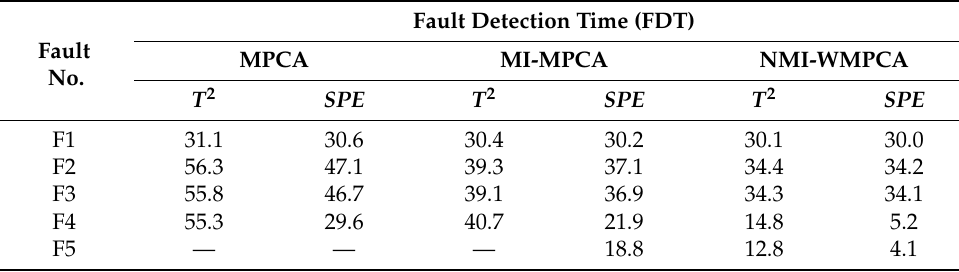
Table 6. Miss detection rate (MDR) based on different methods for all of the fault batches. Fault No.